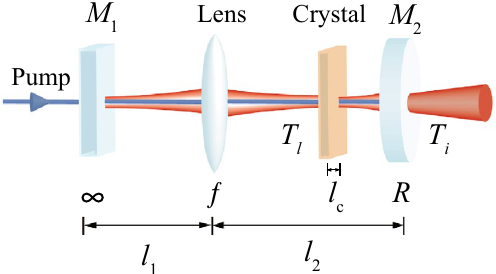
Figure 1. Self-imaging OPO for generating multimode squeezed light. M 1 is a perfect dichroic mirror transmitting the pump and reflecting the squeezed light, and M 2 is a partially reflective mirror having a transmittance of T i for the squeezed light. T l is the transmittance associated with the intracavity loss. The distances between the mirrors and the lens are l 1 and l 2 , as represented in Eq. (9), where detunings (cid:31) l 1 and (cid:31) l 2 are required for stable operation of the OPO 22